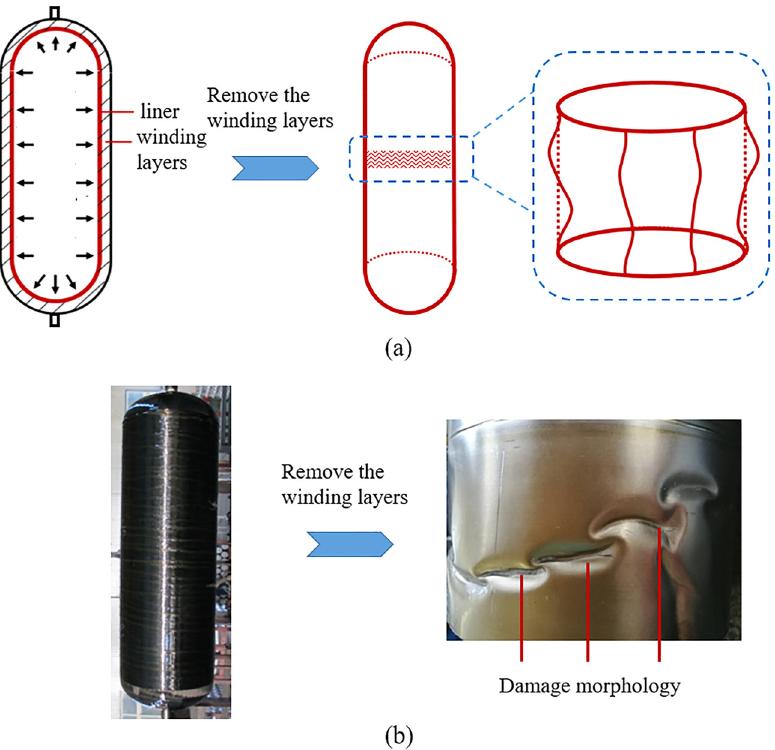
Figure 1: Damaged morphology of COPV with metal liner caused by local buckling in the axial direction. ( a ) Schematic diagram of the axial local buckling of the metal liner and ( b ) damage appearance of the metal liner resulting from axial buckling after the autofrettage